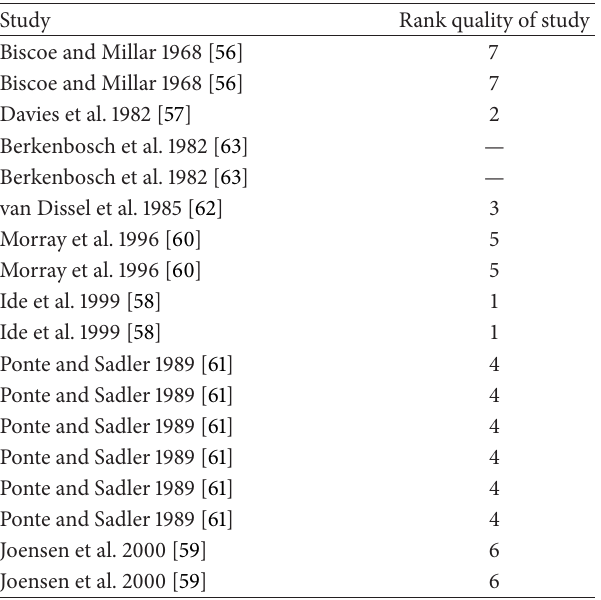
Table 2: Ranking of studies by quality (the Berkenbosch study was not ranked as it examines